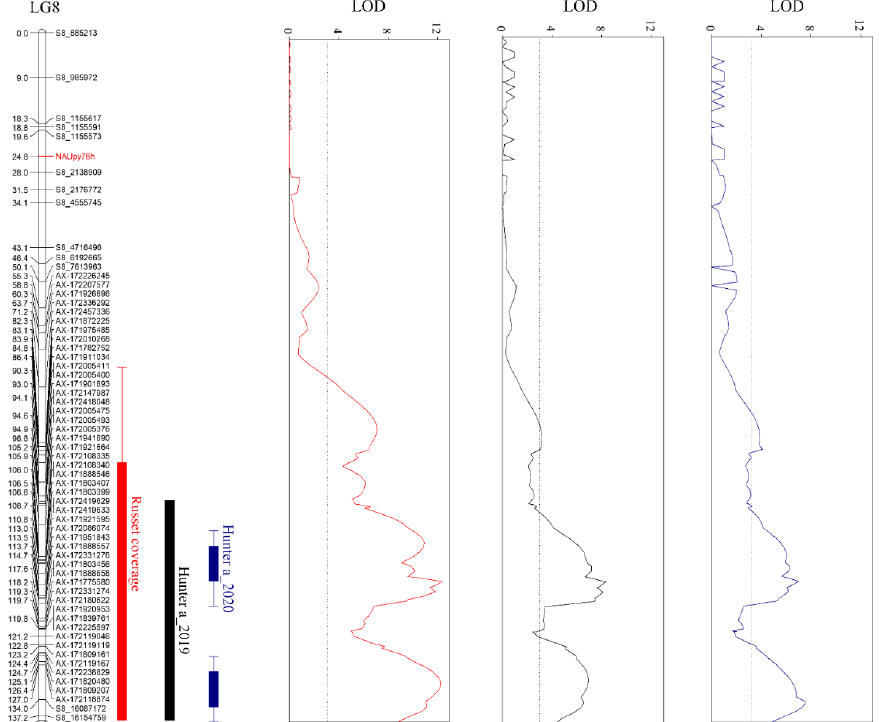
Figure 1. QTLs controlling russet formation on pear fruit skin located in linkage group (LG) 8 of ‘Whangkeumbae’ × ‘Minibae’. The left and right sides of the LG bar indicate genetic distance and anchored markers SNPs, respectively. Logarithm of odds (LOD) threshold is indicated by the dotted line. The three bars located on the right side of LG8 are QTL regions identified using different phenotyping methods. The QTLs and LOD graphs associated with russet coverage, Hunter a in 2019, and Hunter a in 2020 are shown in red, black, and blue, respectively.